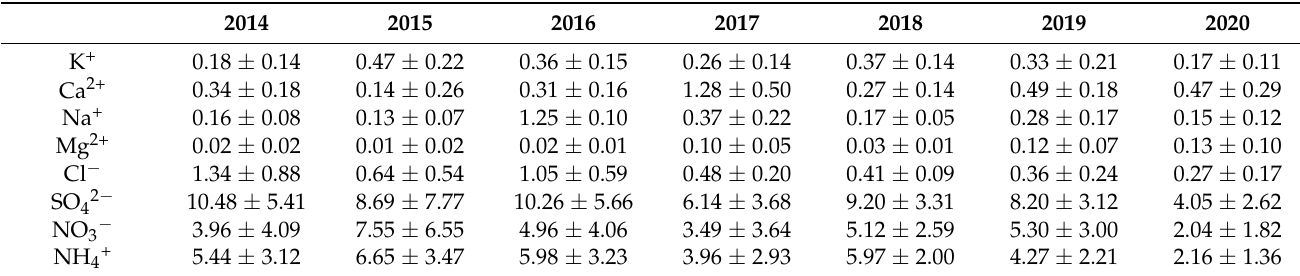
Table 2. Seasonal ion concentrations ( µ g m –3